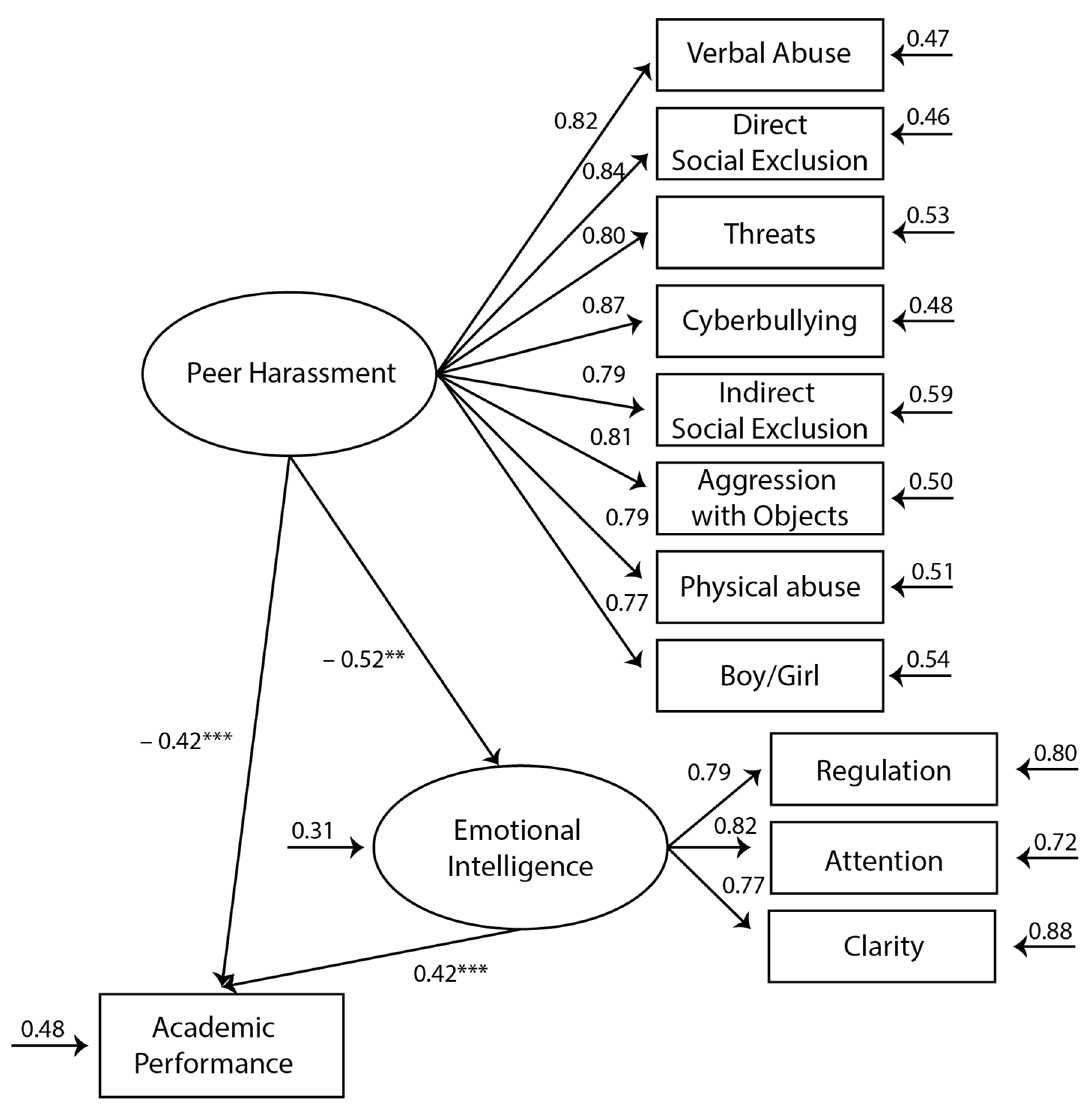
Figure 1. Theoretical model hypothesized through a model of structural equations. All parameters are standardized and statistically significant. Note. *** p < 0.001; ** p < 0.01.